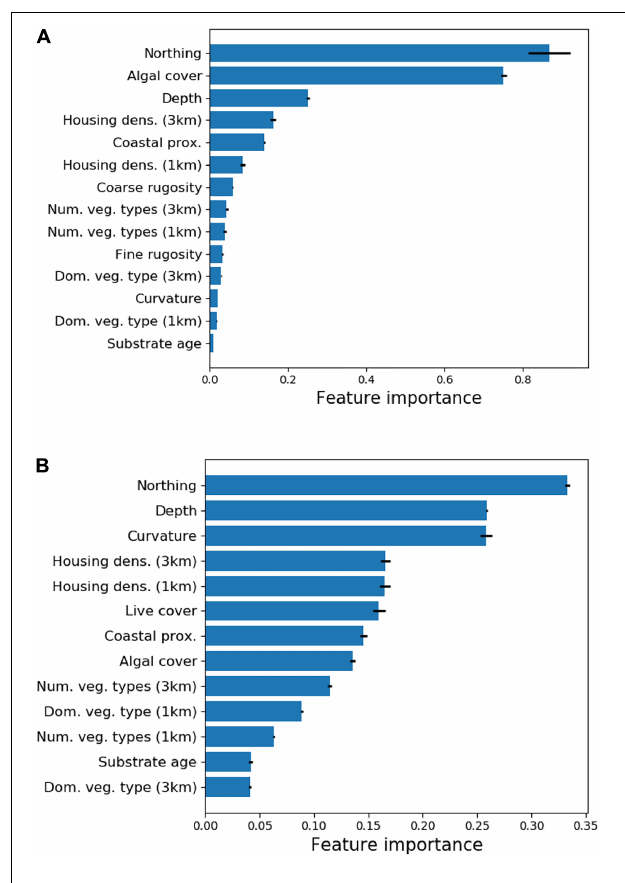
( Table 1 ). For example, stratum 10, which covers a moderate